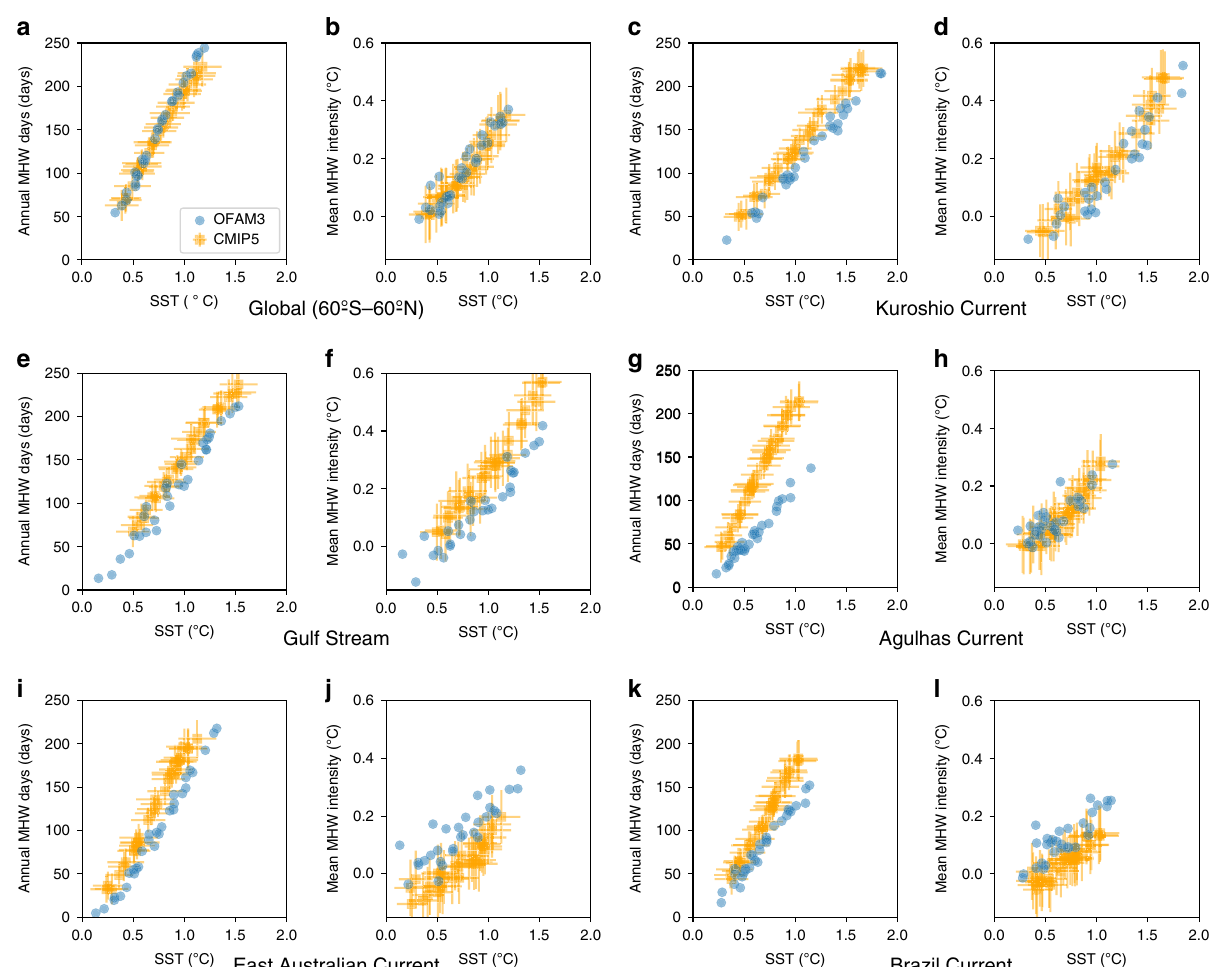
Fig. 7 Relationship between marine heatwaves and sea surface temperature. Spatially averaged projected changes in marine heatwave (MHW) metrics vs. sea surface temperature (SST) during 2021 – 2050 simulated by the 0.1° ocean model (OFAM3) and the multi-model mean product of 23 global climate models (CMIP5) under the Representative Concentration Pathway 8.5. Circles and squares represent anomalies in annual mean MHW days, mean MHW intensity, and annual mean SST relative to their 1982 – 2018 averages over a , b the global ocean (60°S – 60°N), c , d Kuroshio Current, e , f Gulf Stream, g , h Agulhas Current, i , j East Australian Current and k , l Brazil Current. The spatial domains of these western boundary current regions are de fi ned in Fig. 5. Error bars denote the inter-model spread of the CMIP5 models, as determined by standard